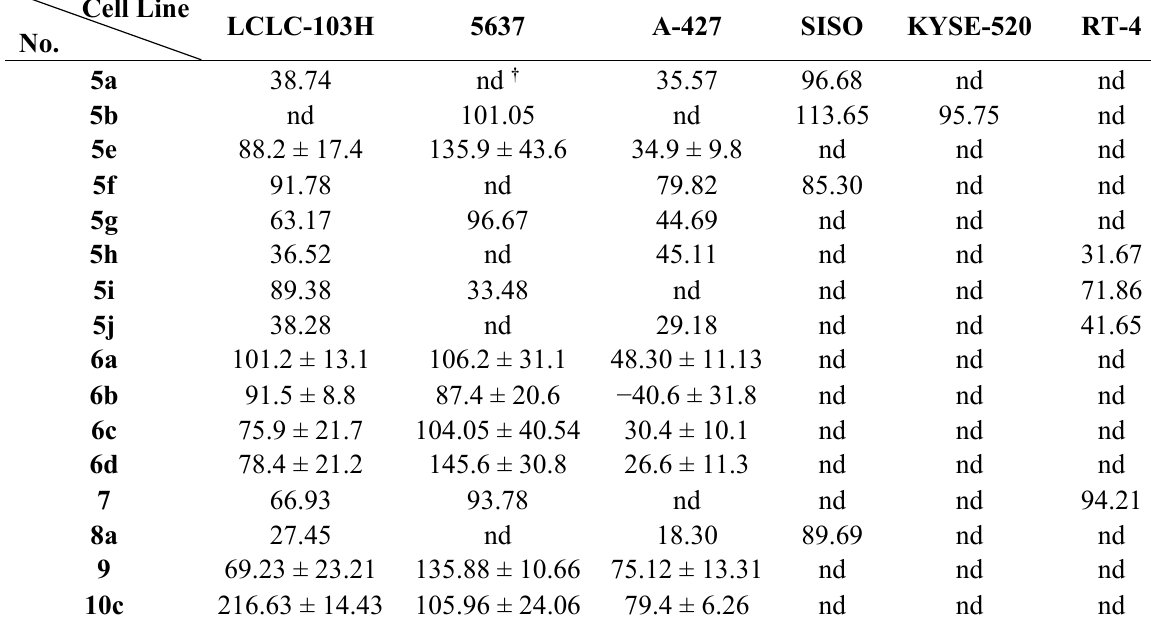
Table 8. Percent of cell growth relative to untreated control at a concentration of 20 µM (values are averages of three independent determinations with standard deviations, otherwise averages of two determinations without SD. Values were calculated according to Equation (2)).